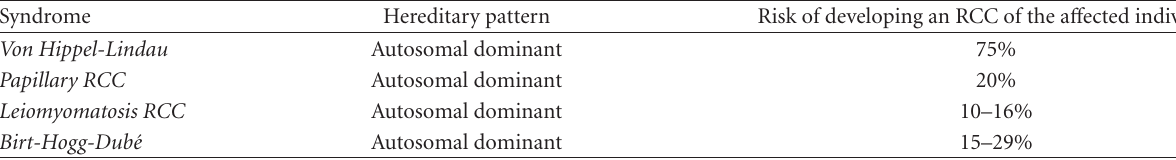
Table 3: Hereditary patterns and risks of renal cell carcinoma (RCC) associated syndromes.